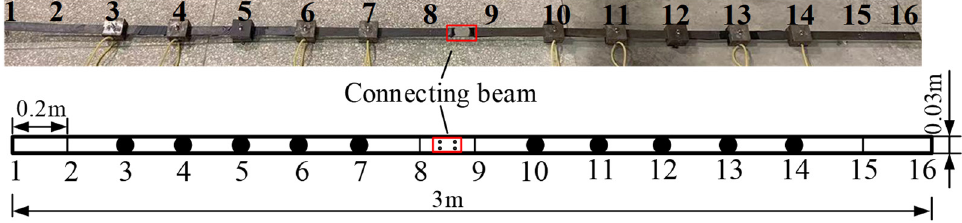
Figure 8. Dimension drawing of flexible beam.